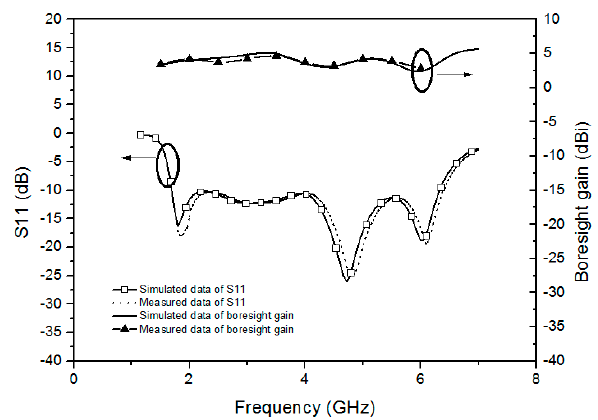
Figure 11. The measured S11 and boresight gain of the proposed BRA compared with simulated data.